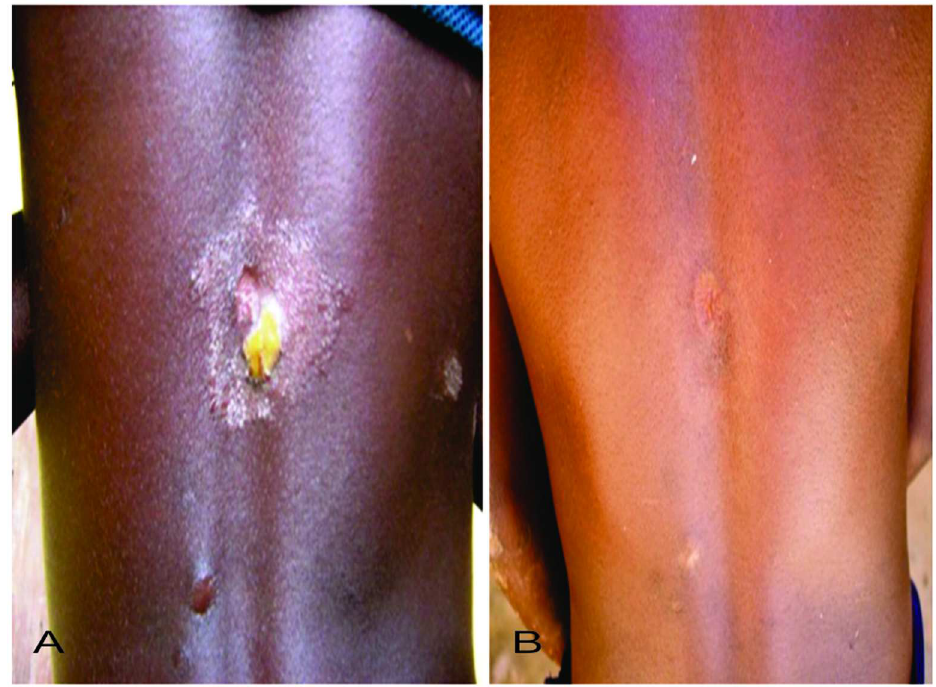
Fig 3. Before and After Treatment with Azithromycin Papillomatous ulcer at the back of patient showing complete healing after 3 weeks of treatment with azithromycin: A. Before Treatment, B. After